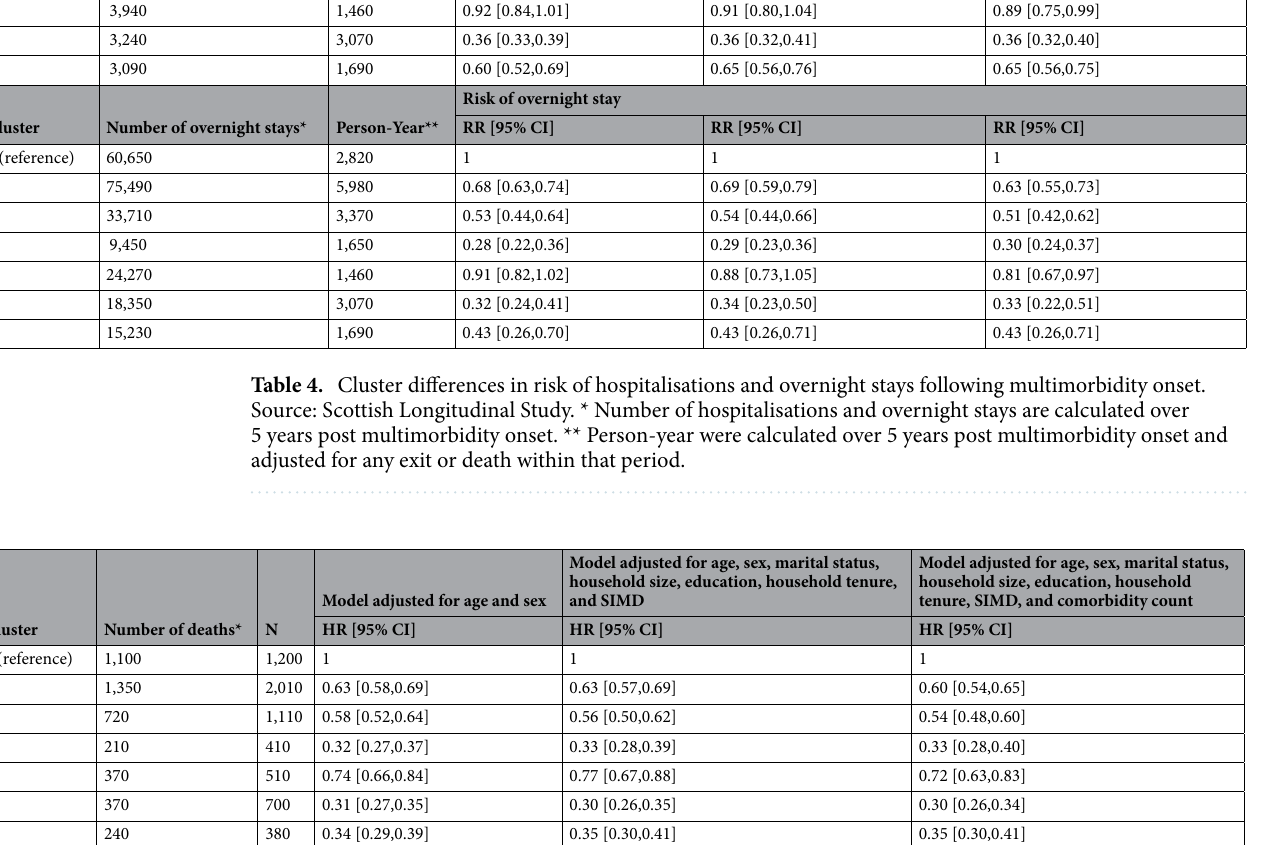
Table 5. Cluster differences in risk of mortality following multimorbidity onset. Source: Scottish Longitudinal Study. *Number of deaths are calculated over 5 years post multimorbidity onset.